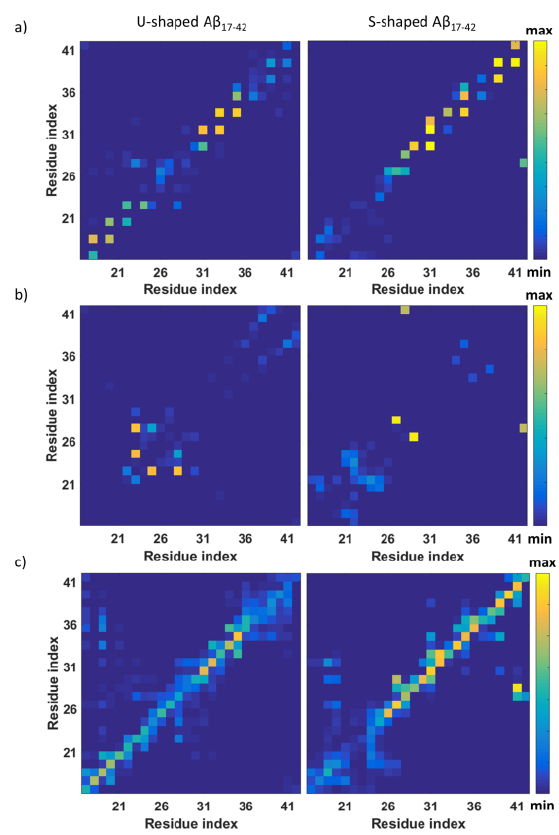
Figure 3. ( a ) U-shaped and S-shaped probability contact maps of inter-chain hydrogen bonds; ( b ) U-shaped and S-shaped probability contact maps of intra-chain hydrogen bonds; ( c ) U-shaped and S-shaped probability contact maps of inter-chain non-bonded contacts.